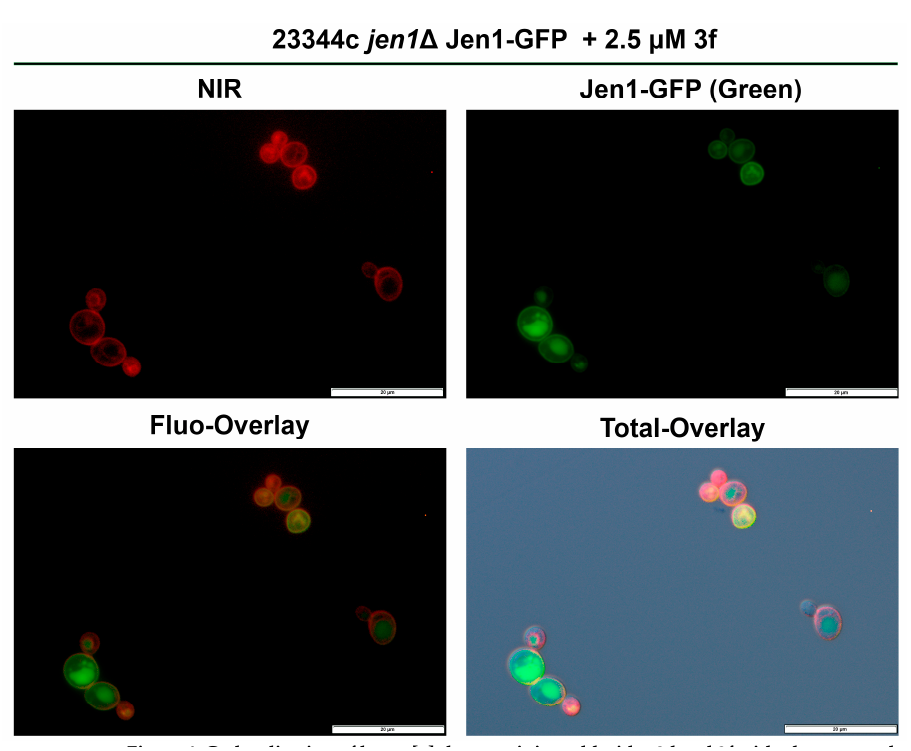
Figure 4. Co-localization of benzo[ a ]phenoxazinium chlorides 3d and 3f with plasma membrane. Fluorescence microscopy images of 23344c jen1 Δ Jen1-GFP cells after incubation with 3d and 3f (2.5 µM) for 1 h. Samples were rinsed two times in PBS 1× and mounted on a slide for observation with a 60× oil immersion objective, using the adequate filters U-FDICT, ET-CY5-FAR-RED (exciter filter: 595–645 nm/emission filter: 665–715 nm), and TLV-U-FF-FITC (exciter filter: 455–495 nm/emission filter: 505–555 nm). Representative images of three independent experiments. Scale bar 20 µm.